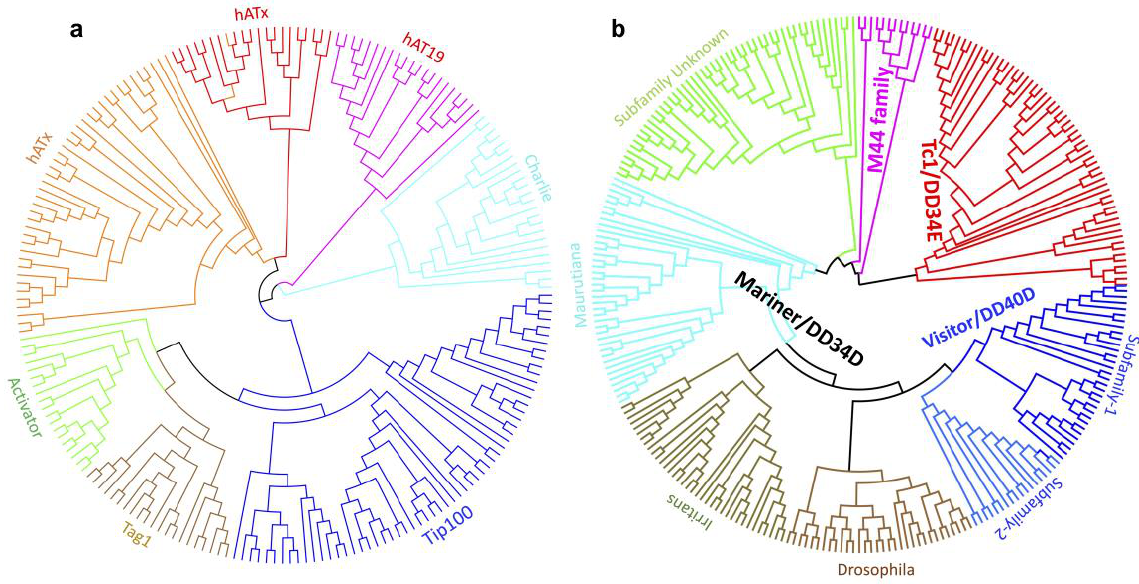
Figure 3. Phylogenetic classification of the two major superfamilies of Class II TEs in the genome of S. chinensis . ( a ) Classification of 207 full-length representative sequences from hAT superfamily, classify- ing them into six known families. ( b ) Classification of 287 full-length representative sequences of the Tc1/mariner superfamily into four prominent families and one unknown clade. The Mariner family is divided into three subfamilies using known reference sequences from GenBank. DD40D/Visitor is identified for the first time in aphids in this study. The M44 is the new uncharacterized family, and sequences in this analysis were placed in this family following the Dfam.org